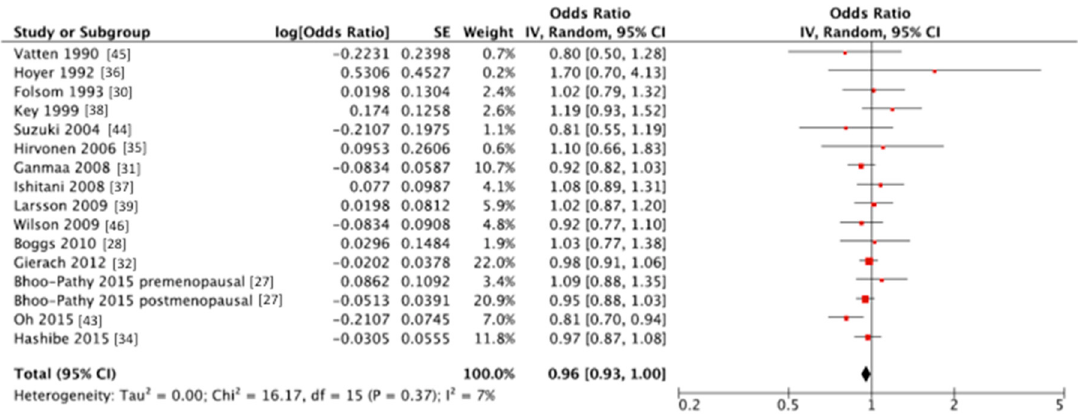
Figure 2. Forest plot of summary relative risks (RRs) of breast cancer for the highest versus lowest (reference) category of coffee consumption. SE = standard error; CI = confidence interval; IV = instrumental variable. Table 2. Subgroup and additional analyses of studies reporting risk of breast cancer for the highest versus lowest (reference) category coffee consumption.